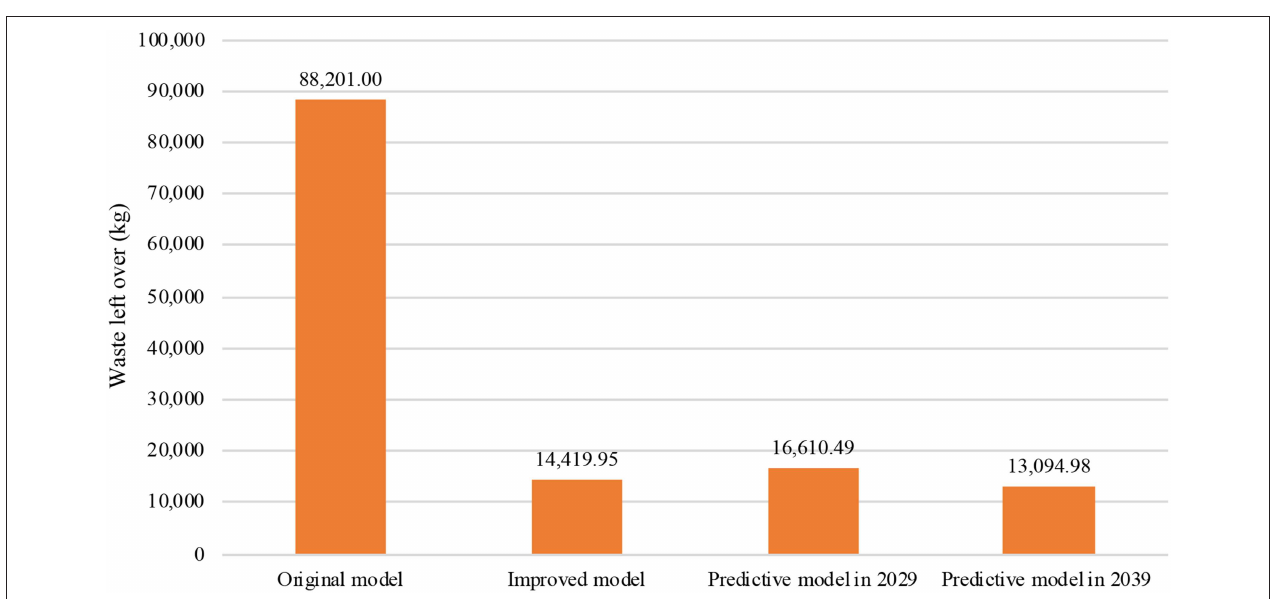
FIGURE 5 | The comparison of left-over waste between the original model, improved model, predictive model in 2029 and 2039.